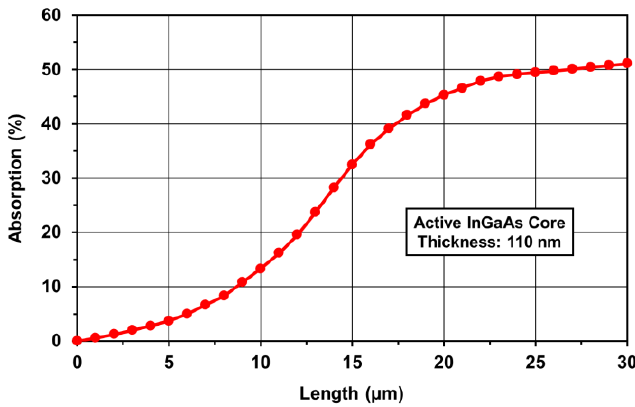
Figure 4. Simulated absorption at the optical wavelength of 1.55 μm plotted versus the length of the TTR-PD waveguide with an InGaAs core width of 2 µm.